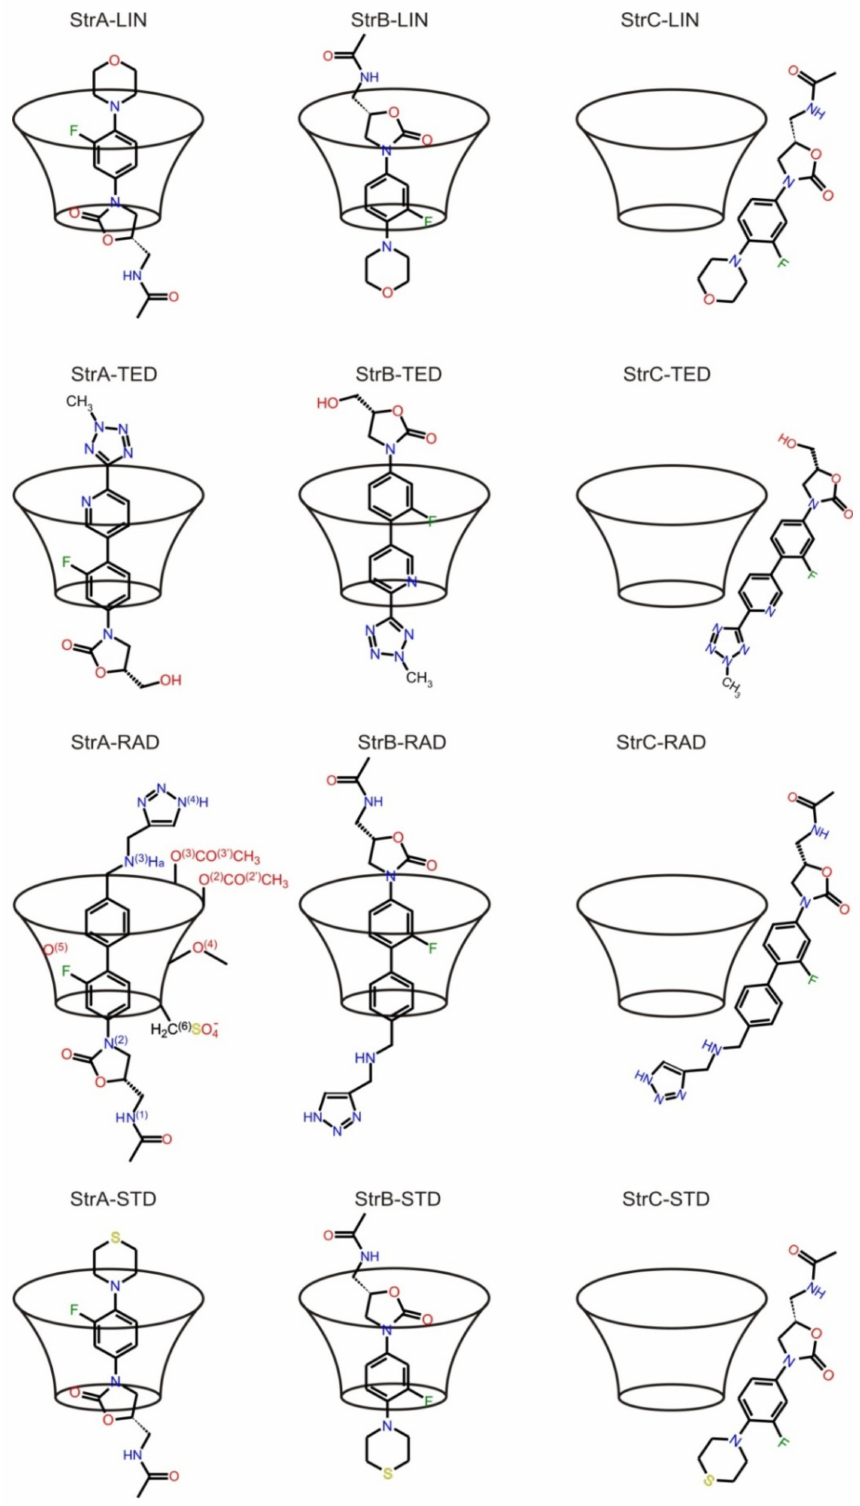
Figure 2. Schematic representation of TED, RAD, SUT [12], and LIN [5] complexes with HDAS- β